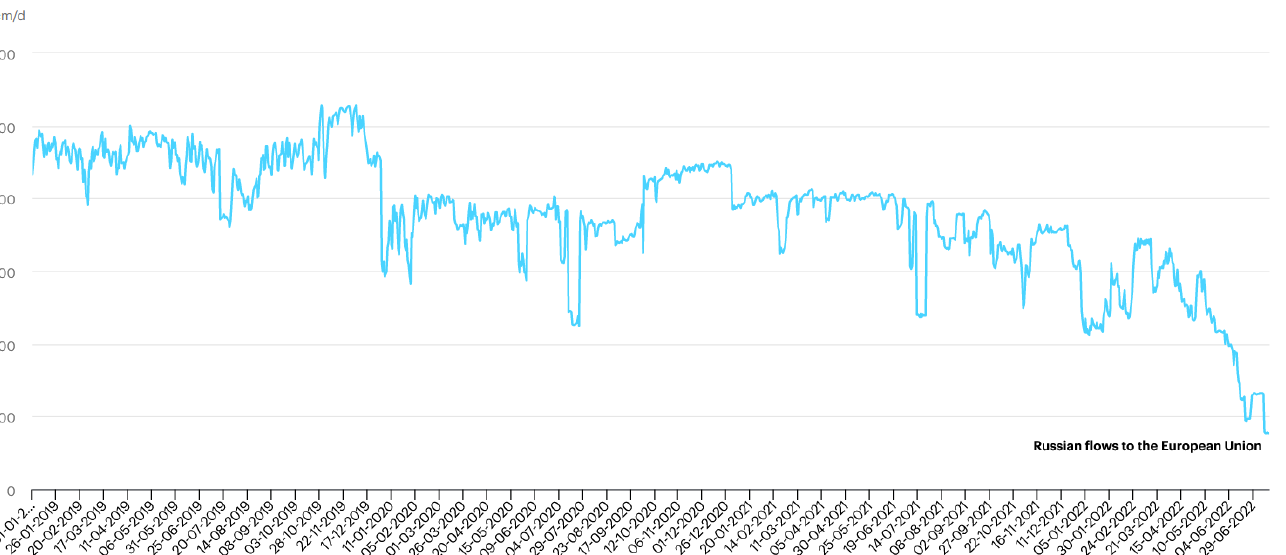
Figure 5. Russian gas flow to the European Union. These data can be found here: https://eu- observer.com (accessed on 20 March 2022).